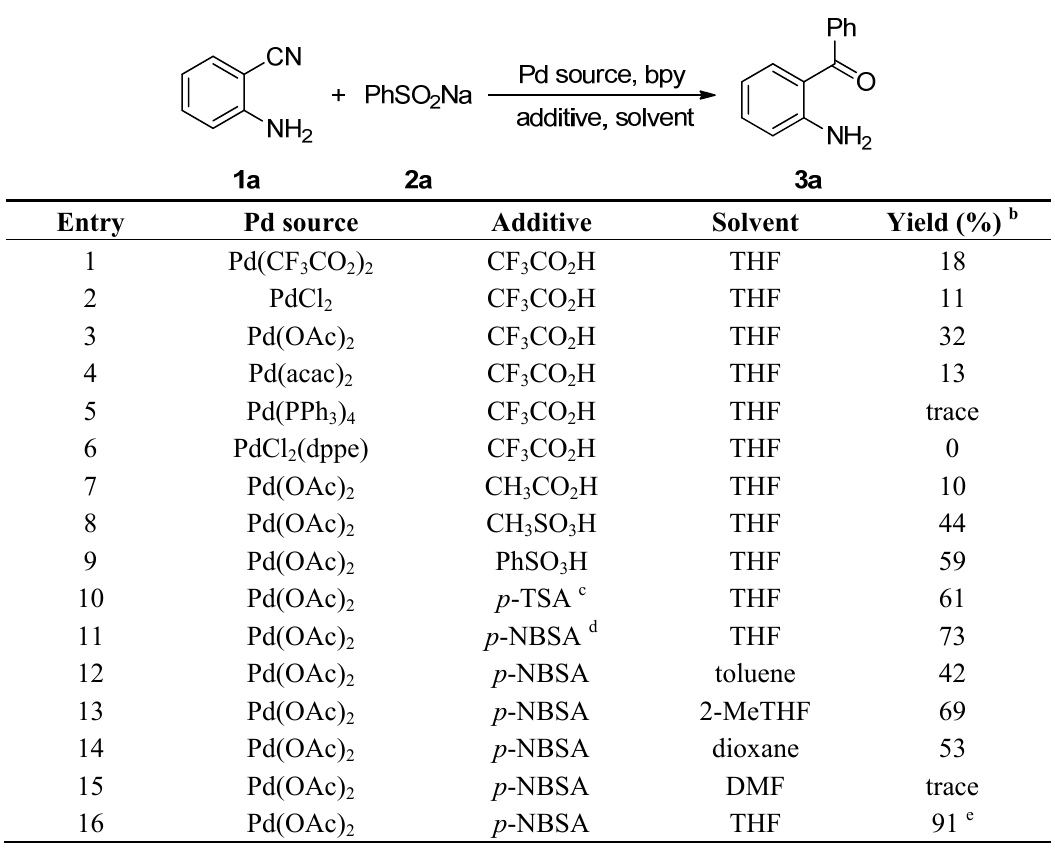
Table 1. Optimization of the reaction conditions a